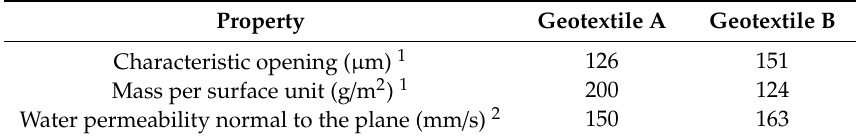
Figure 2. Geotextiles utilized in the laboratory campaign. Geotextile A (left) and Geotextile B (right). Table 2. Initial properties of the tested geotextiles.